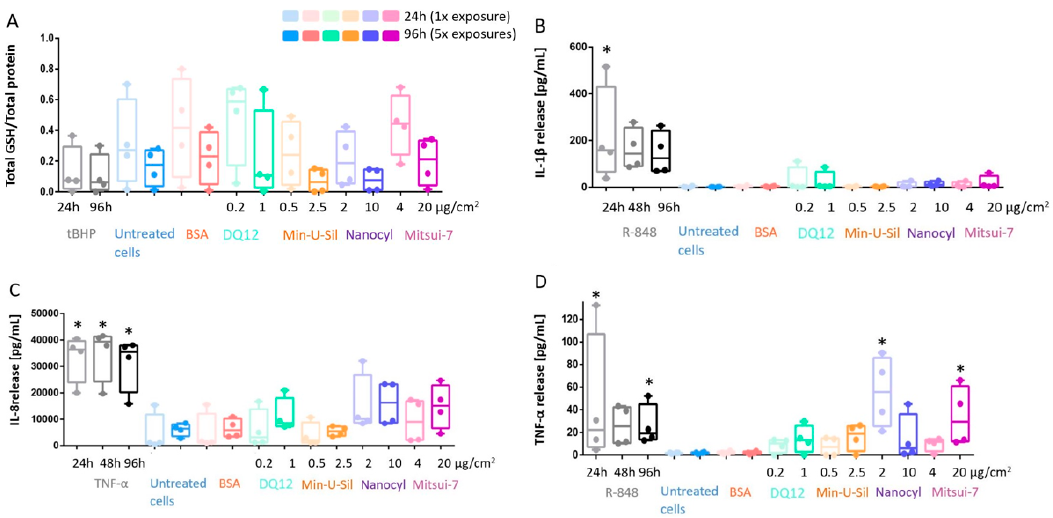
Figure 4. In response to exposure to the tested materials, the extent of oxidative stress and proinflammatory response is assessed via ( A ) GSH content; ( B ) IL-1 β ; ( C ) IL-8 and ( D ) TNF- α release measurements. Data presented in a boxplot with 10–90 percentile. * marks a statistically significant increase compared to the negative control, n = 4.